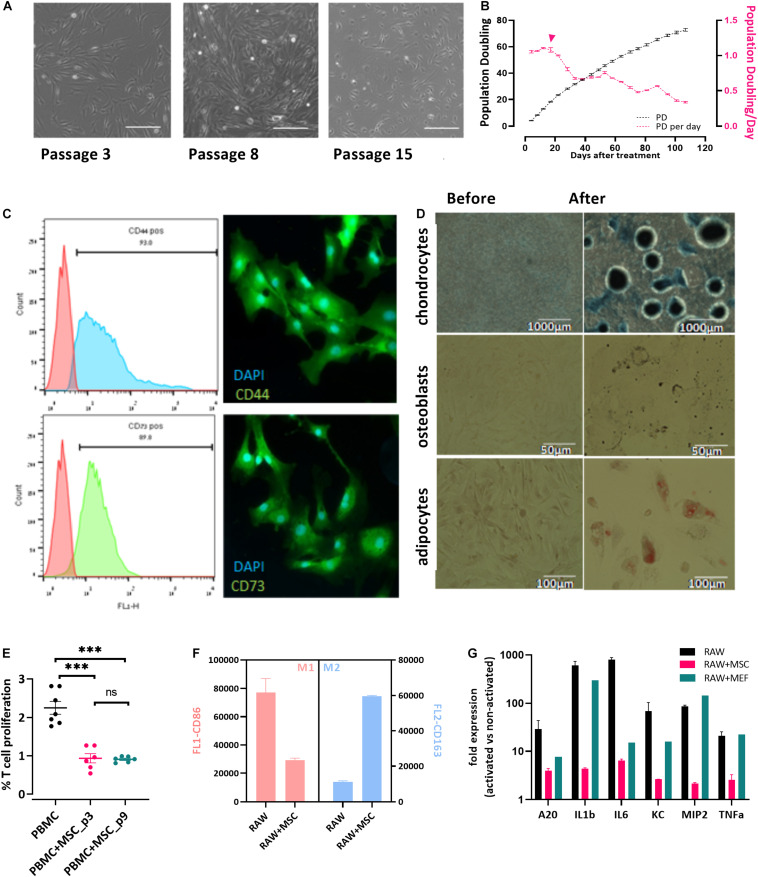
Cells isolated from cow’s umbilical cord display known MSC characteristics. (A) bUC-MSC displays a spindle-shaped morphology, proliferates, and adheres to plastic surfaces. No changes in cell morphology were observed for up to eight passages, but at passage 15, proliferation slowed. Scale bar = 500 μm. (B) bUC-MSC total population doubling (PD, black line) and population doubling time (PDt, pink line) for 25 passages. Population doubling was calculated as described in the “Materials and Methods” section. (C) Immunophenotyping (by flow analysis, left panel) and fluorescent microscopy imaging (right panel, with DAPI staining for nucleic acid, scale bars = 50 μm) of CD44 and CD73 MSC markers. (D) bUC-MSCs can differentiate into chondrocytes, osteoblasts, and adipocytes (stained by Alcian blue, Alizarin red, and oil red O, respectively). (E) T-cell proliferation assays were performed using bovine peripheral blood mononuclear cell (PBMC) activated by Con-A and cocultured with bUC-MSCs for 4 days at a MSC: PBMC ratio of 1:5. Cell proliferation was determined by MTT assay. The results represent the fold change between the Con-A–activated and nonactivated PBMCs, measured by the absorbance at 540 nm, and the activation of PBMC alone was set to 1. Data are mean ± SEM for n = 6, and Student t-test was used for comparison of means. ***p < 0.001. (F) Macrophages cell line (RAW) was cocultured with bUC-MSCs for 21 h and then activated by LPS for 3 h. RAW cells without bUC-MSCs were examined as reference cultures. RAW cells were then stained and flow-analyzed with proinflammatory M1 (pink bars, CD86) or anti-inflammatory M2 (blue bars, CD163) distinctive antibody. Mean fluorescence intensity ± SEM is indicated for n = 3. All bars are significantly different (p < 0.01) by Student t-test. (G) The transcriptional profile of five mouse genes was investigated by RT-qPCR on RNA extracted from the activated macrophages with or without cocultured bUC-MSC or MEF negative control. The expression levels of typical proinflammatory genes were reduced in RAW cells cocultured with bUC-MSCs but not with MEFs. Three housekeeping genes were used as reference genes—UBC, EIF5a, and EEF1A1. Data are mean ± SEM for n = 3 of RAW, RAW + MSC, and n = 2 for RAW + MEFs.